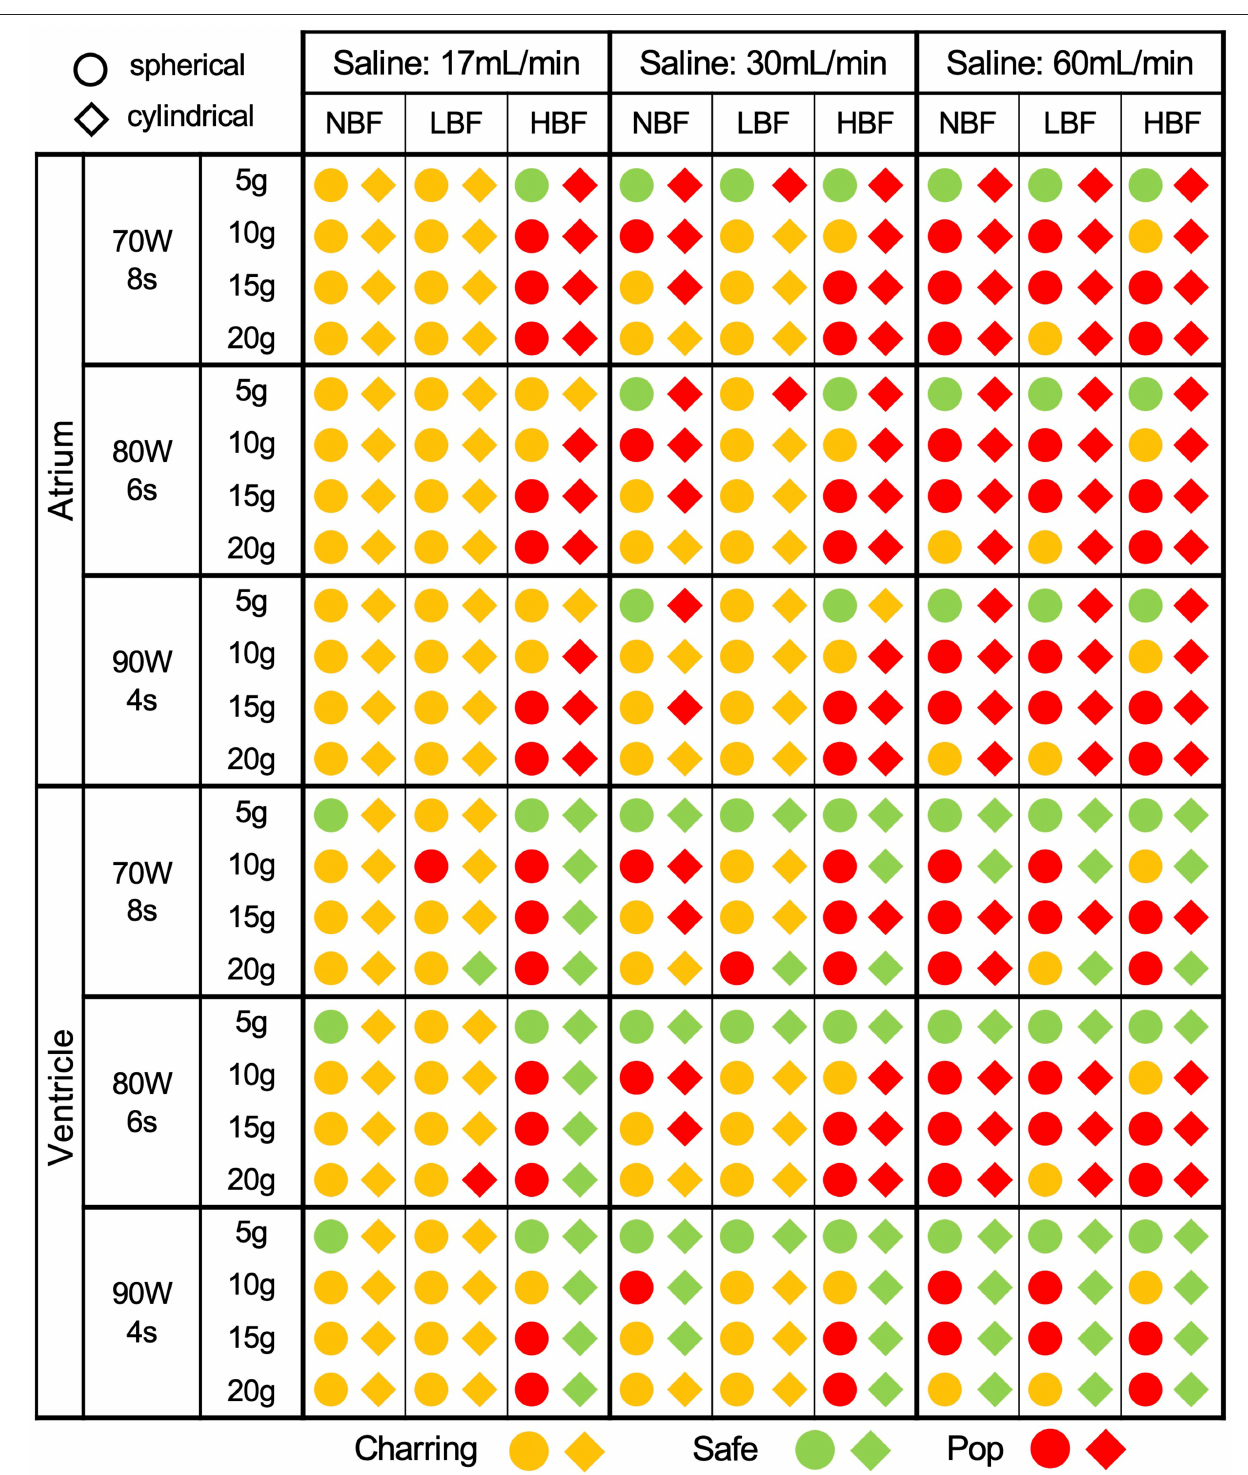
FIGURE 2 | Safety outcomes of HPSD protocols according to the different parameters in Table 1 . HBF, high blood-flow (0.5 m/s); LBF, low blood-flow (0.1 m/s); NBF, no blood-flow (0.0 m/s).